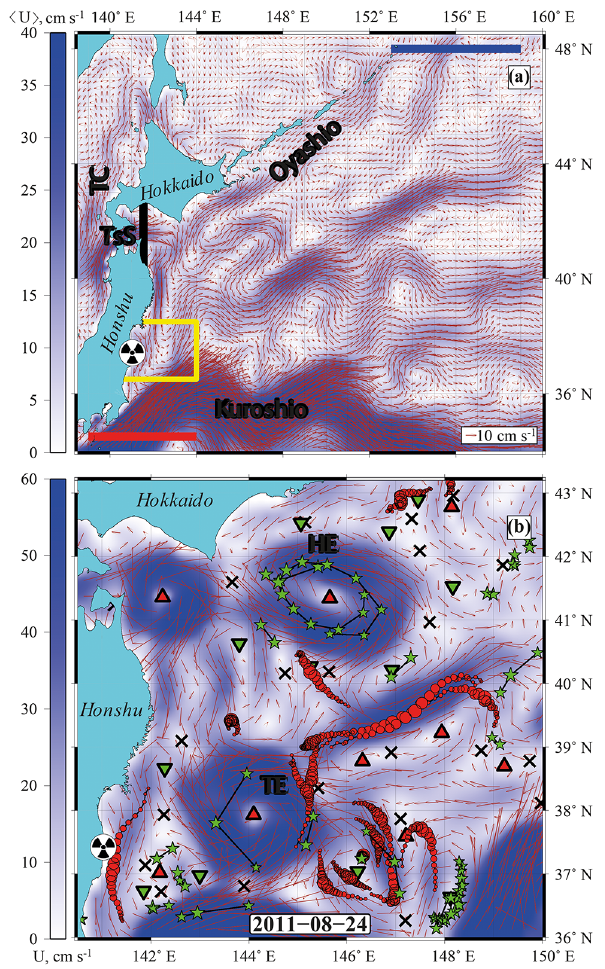
Figure 1. (a) The AVISO velocity field in the Kuroshio–Oyashio confluence zone, averaged from 1993 to 2016. TsS stands for the Tsugaru Strait. Location of the FNPP is shown by the radioactivity sign. The area just around the FNPP is shown by the yellow lines. (b) The velocity field on 24 August, 2011, with the Tohoku (TE) and Hokkaido (HE) eddies studied in the paper and with tracks of some available drifters (the red circles) and Argo floats (the green stars) present in the area at that time. Elliptic and hyperbolic stag- nation points with zero mean velocity are indicated by triangles and crosses, respectively, with upward- and downward-oriented trian- gles denoting anticyclones and cyclones,